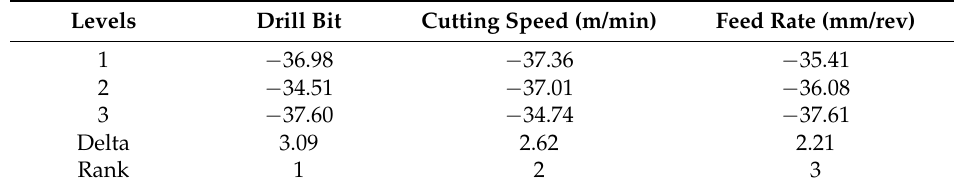
Table 4. S/N ratio response table (smaller is better) of thrust force for (Mg/SiC/GNPs) hybrid MMC. Levels Drill Bit Cutting Speed (m/min) Feed Rate